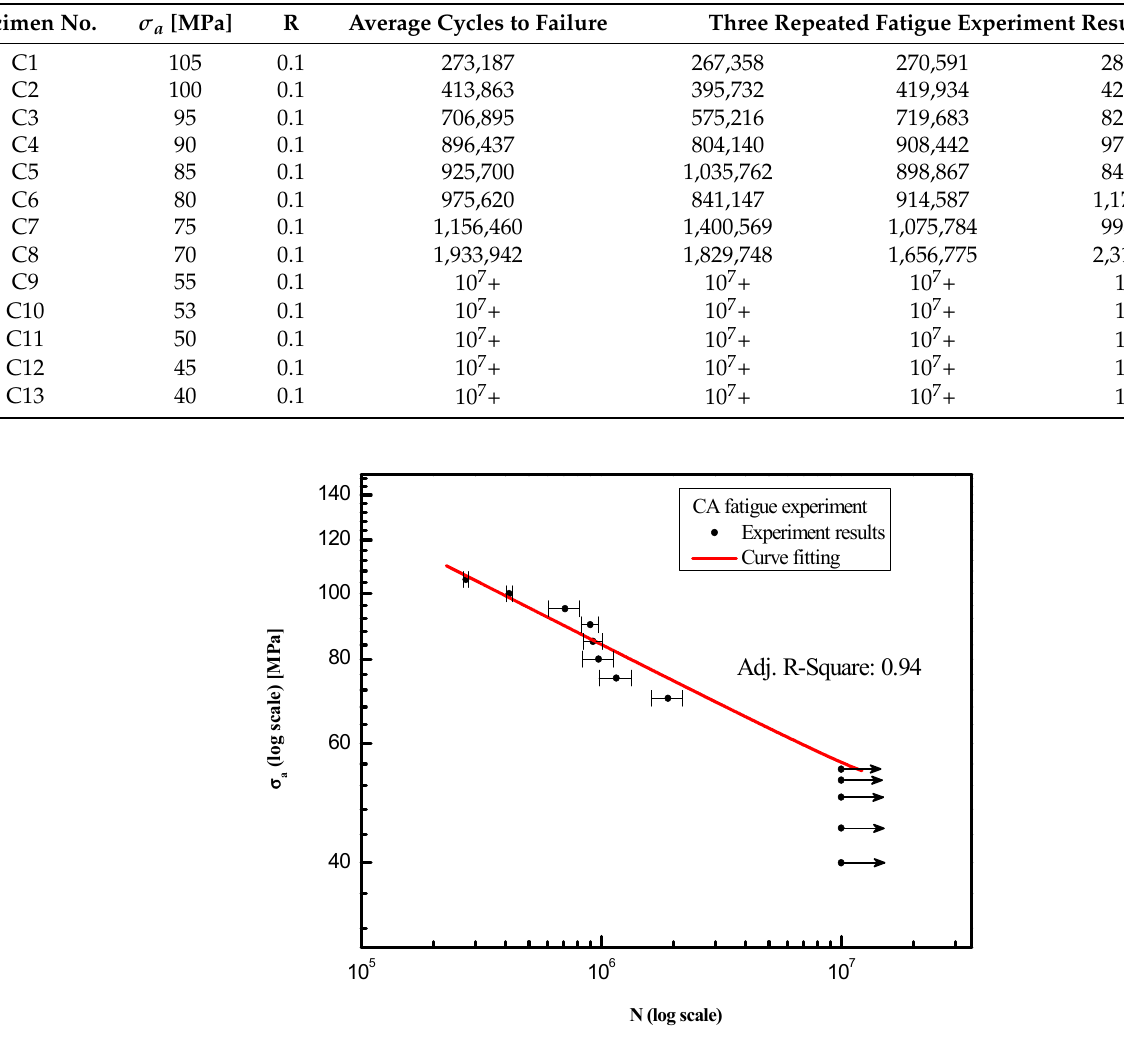
Figure 8. Results of experimental data and fitting curve.